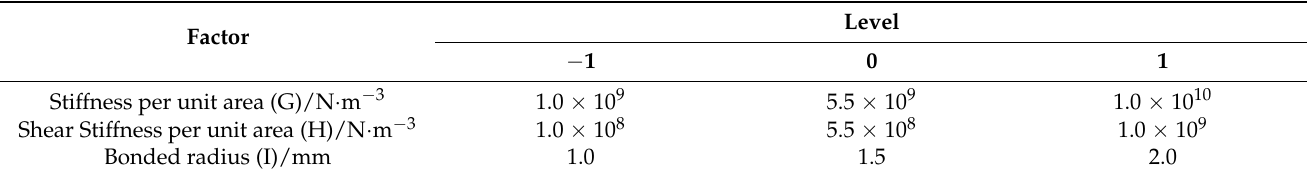
Table 2. Bonding parameter.